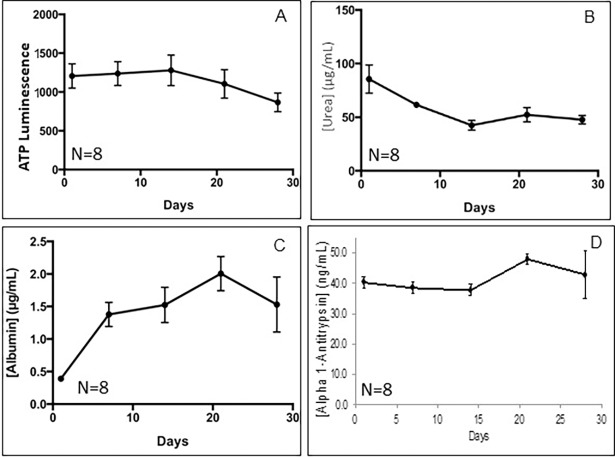
Expression of liver markers during long-term culture.(A) Cellular ATP expression indicates that viability only drops by approximately 10% over 28days. (B) Although albumin levels excreted into the medium are initially relatively low, expression triples by 7 days and thereafter remains high over the entire 28 day period. (C) Urea synthesis dropped somewhat but remained at over 50ug/ml at day 28. (D) Hepatocyte alpha-1 antitrypsin levels remain constant over the entire 28 day period.